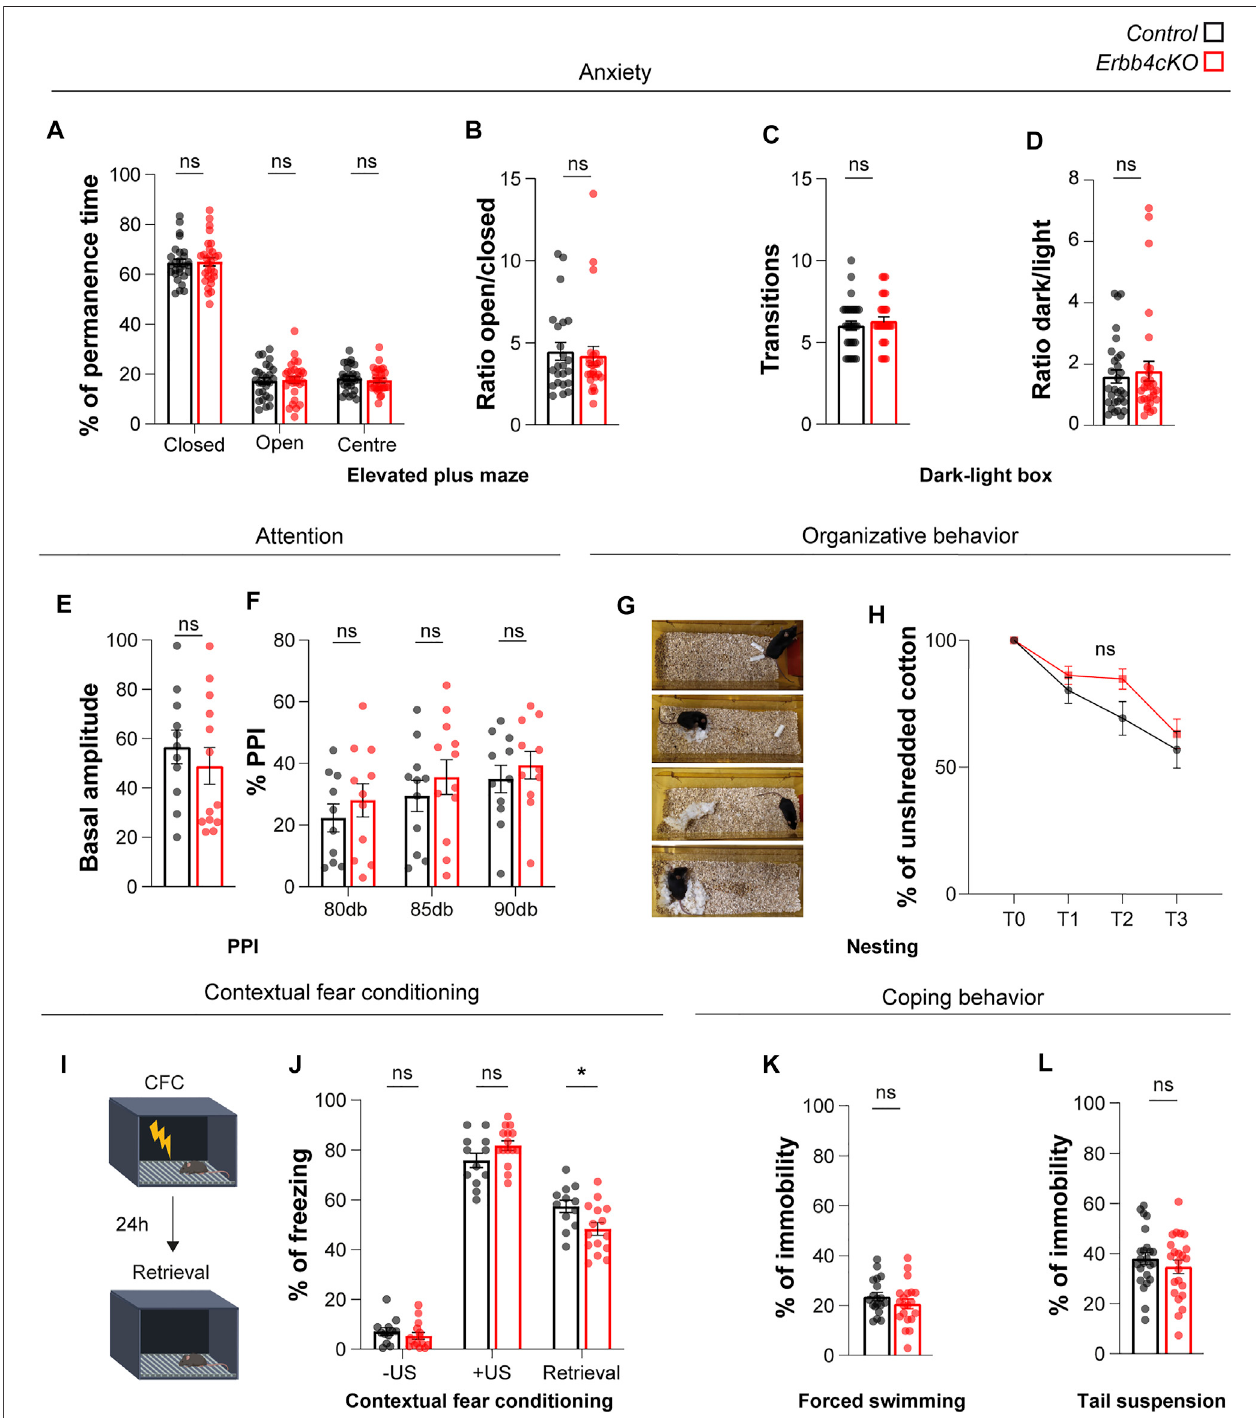
FIGURE 6 | Mice with Erbb4 deletion in Pet1 + neurons display fear memory de fi cits but do not show abnormalities in anxiety or organizational behavior. (A) Percentage of permanence time the closed arms, open arms and centre of the elevated plus maze test. (B) Ratio of permanence time in the open arms over the closed arms during the elevated plus maze test. (C) Number of transitions between lighted and dark areas in the light-dark box test (D) Ratio between dark and light permanence time in light-dark box test. (E) Basal amplitude of startle re fl ex for control and Erbb4cKO mice. (F) Percentage of prepulse inhibition (PPI) of startle response for control and Erbb4cKO mice. (G) Sample images of four different time points during the nest building test. (H) Percentage of unshredded cotton used by mice for building a nest at 0, 1, 2, and 3 h after providing them with new material. (I) Diagram of contextual fear conditioning (CFC) test (mo fi died from Biorender.com). Retrieval test was performed 24 h after CFC by placing the mouse in the same context. (J) Percentage of freezing for each phase of the CFC learning and retrieval. -US: